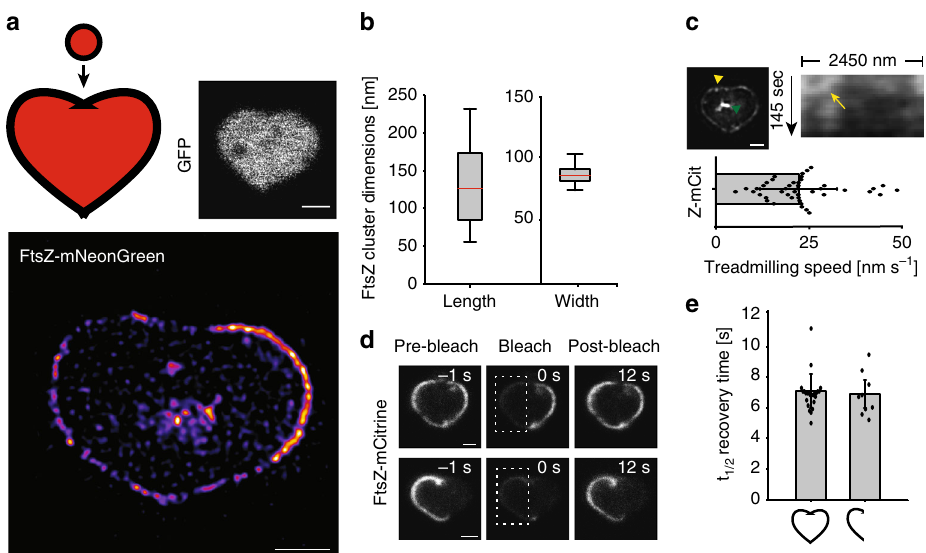
Fig. 5 FtsZ cluster dimensions and dynamics in heart-shaped cells. FtsZ behavior in E. coli cells sculpted into heart shapes. a Upper left, Cartoon representation of a WT E. coli cell and a heart shape (both colored red for visualization), highlighting the large and complex structural changes of a cell-to- heart transition, approximately to scale. Upper right, Drug-treated cell expressing cytoplasmic GFP, shaped as a heart. Lower, STED image of an FtsZ-heart (FtsZ-mNeonGreen) in a drug-treated E. coli cell. b Lengths and widths of 155 individual FtsZ-mNeonGreen fl uorescence clusters in cells shaped as hearts. Average length = 129 ± 44 nm and width = 84 ± 9 nm. Boxes represent S.D., with red lines indicating mean. Whiskers on the box plots encompass 95.5% of the distribution. c Upper row, SIM image from a time-lapse series (epi- fl uorescence) of a heart-shaped cell expressing FtsZ-mCitrine. Green arrowhead indicates internal FtsZ clustering. Corresponding kymograph is shown adjacent to the image, and was generated starting at the yellow arrowhead in the SIM image, moving counter-clockwise for the indicated length. The yellow arrow points to an FtsZ trajectory. Lower, average treadmilling speed of FtsZ- mCitrine (Z-mCit) clusters in hearts (22.6 ± 10.4 nm s − 1 , n = 44). d FRAP measurements of FtsZ-mCitrine in heart-shaped cells. Top row, bleaching of half the FtsZ-mCitrine molecules in a full heart. Bottom row, bleaching of a half-full heart. No difference in recovery times was observed. e Histogram of average t n = 24), recovery in half-hearts: 6.9 ± 0.9 s ( n = 9). Scale bars 1/2 recovery times calculated from FRAP measurements. Recovery in full hearts: 7.1 ± 1.1 s ( = 1 μ m. Dots represent individual data points, bars represent mean with error bars representing S.D